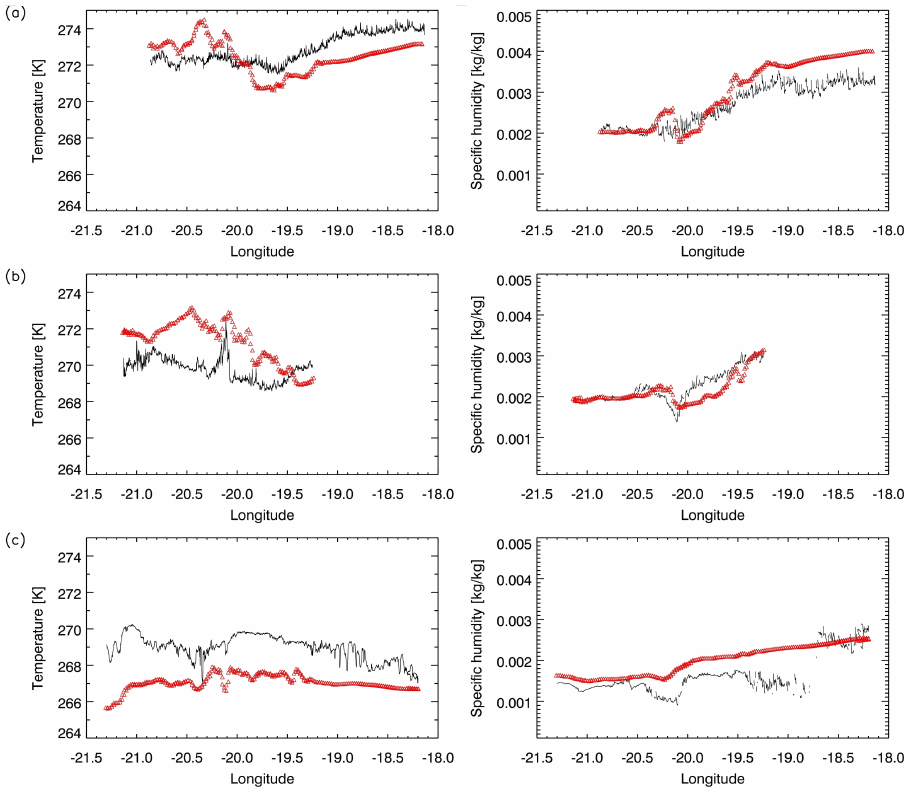
Fig. 11. As in Fig. 10 but for temperature [K] (panels on the left) and specific humidity [kgkg − 1 ] (panels on the